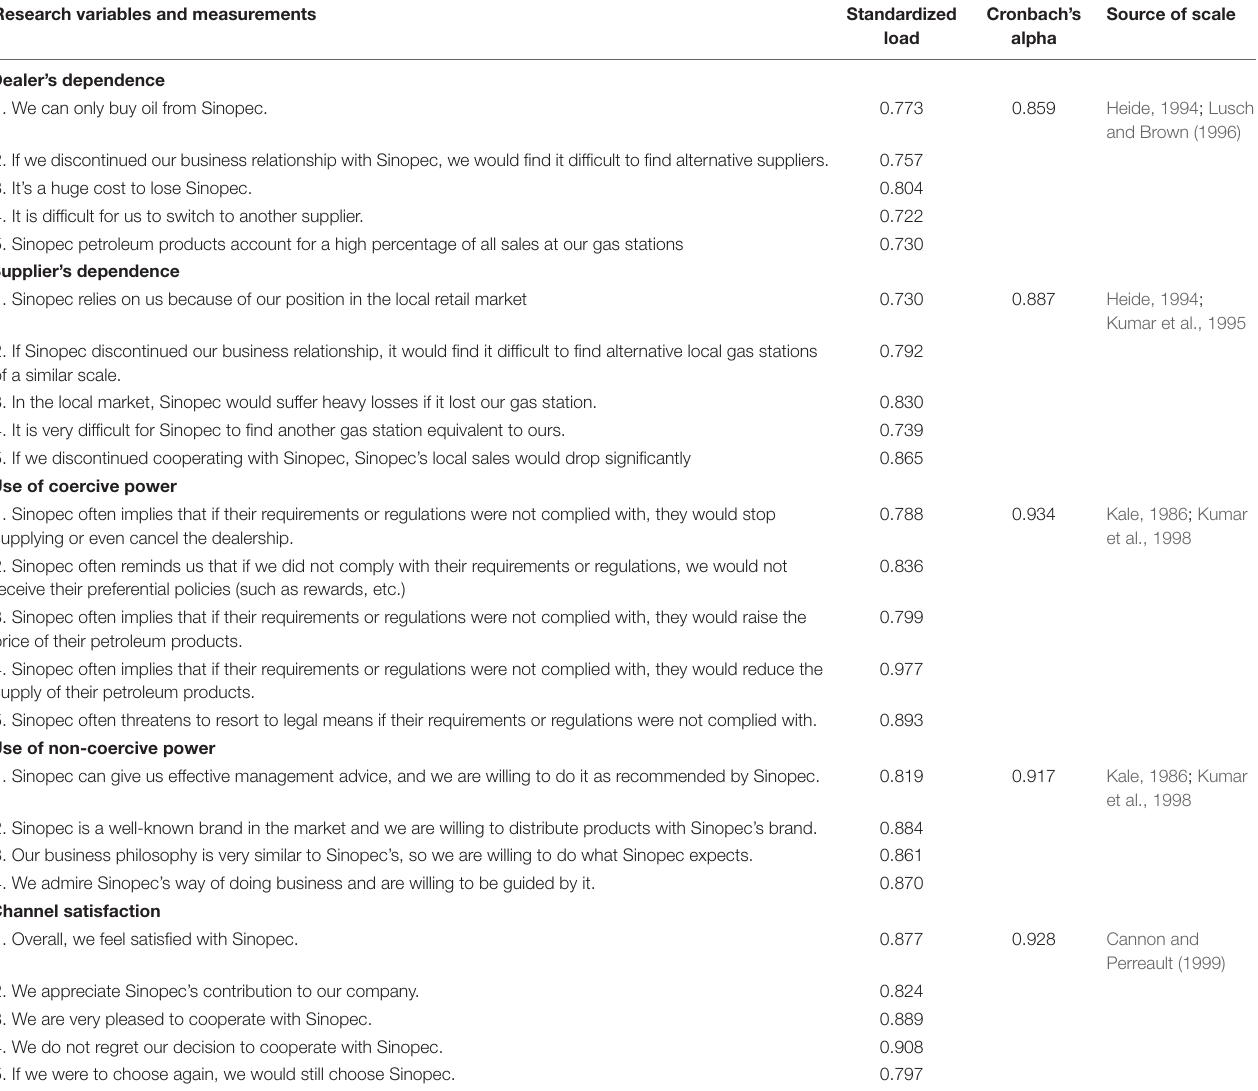
TABLE 1 | Research variables and measurements.